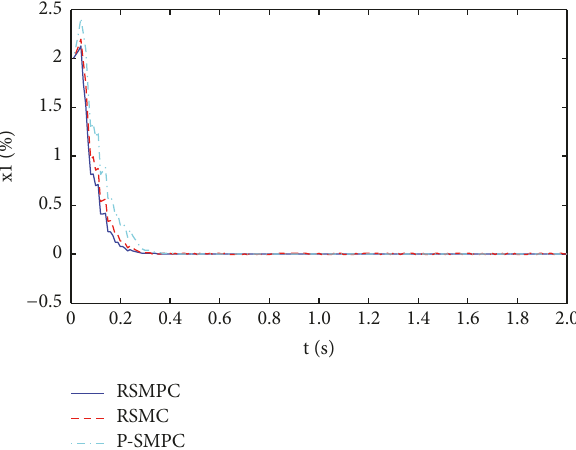
Figure 7: Response curves of system state 𝑥 1 under disturbance condition